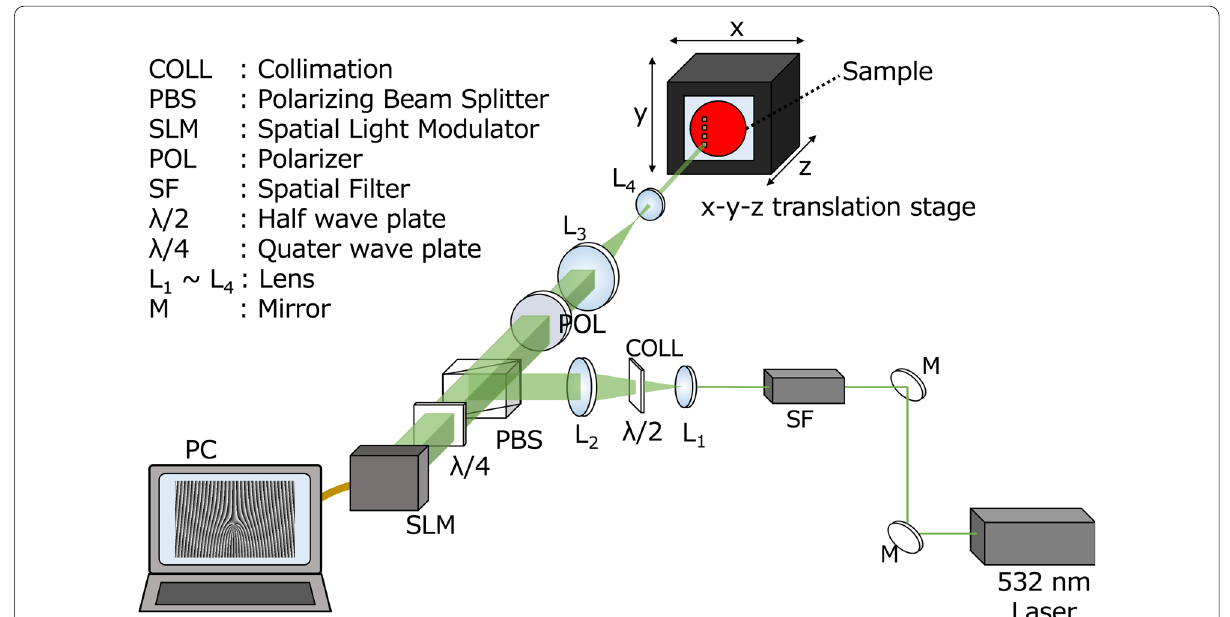
Fig. 5 Schematic of the optical printing set-up built on the optical table for digital hologram printing